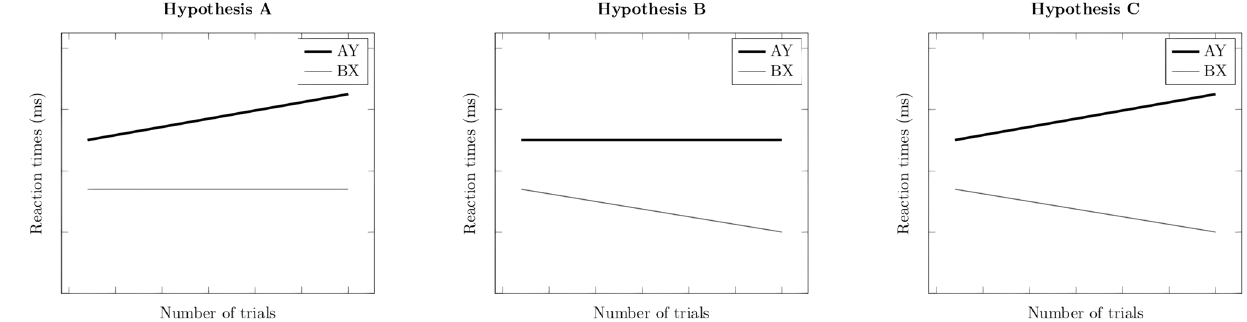
Figure 1. Graphical representations of the three alternatives to explain the increase in AY—BX difference with the increase in the number of trials. Greater proactive behavioral index in studies with larger number of trials could be guided by three alternatives: the increase in proactive control reflected in the progressive increase of AY trials RTs ( A ), the decrease in reactive control reflected in the progressive decrease in RTs in BX trials ( B ), or the combination of both patterns ( C